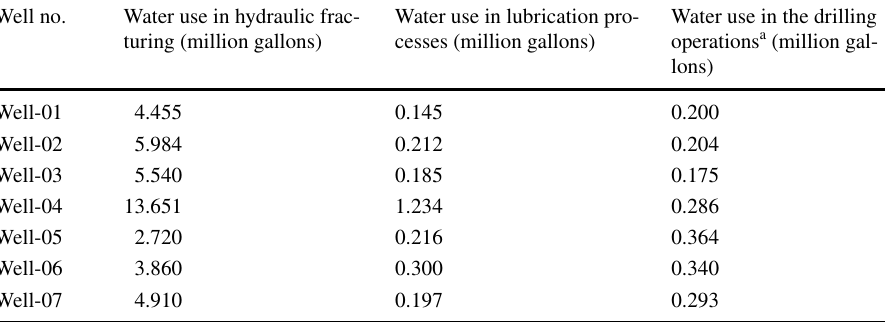
Table 3 Uses of water volume in each